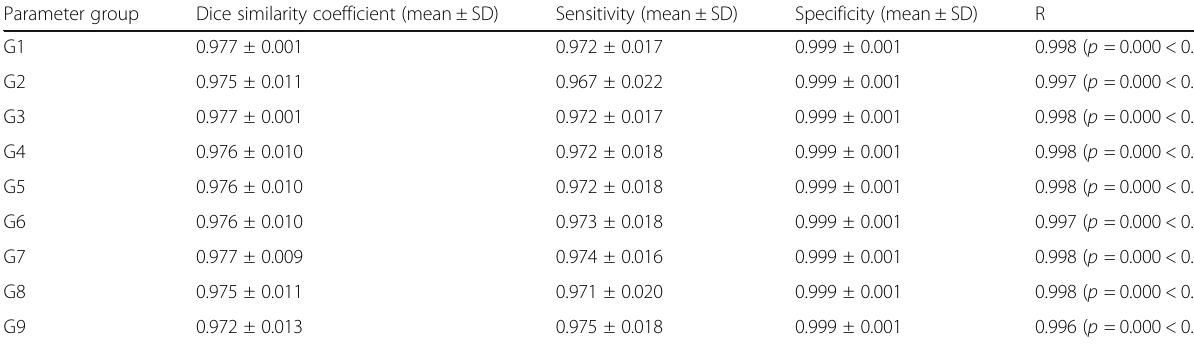
Table 2 Segmentation performance of the proposed method in each parameter group Parameter group